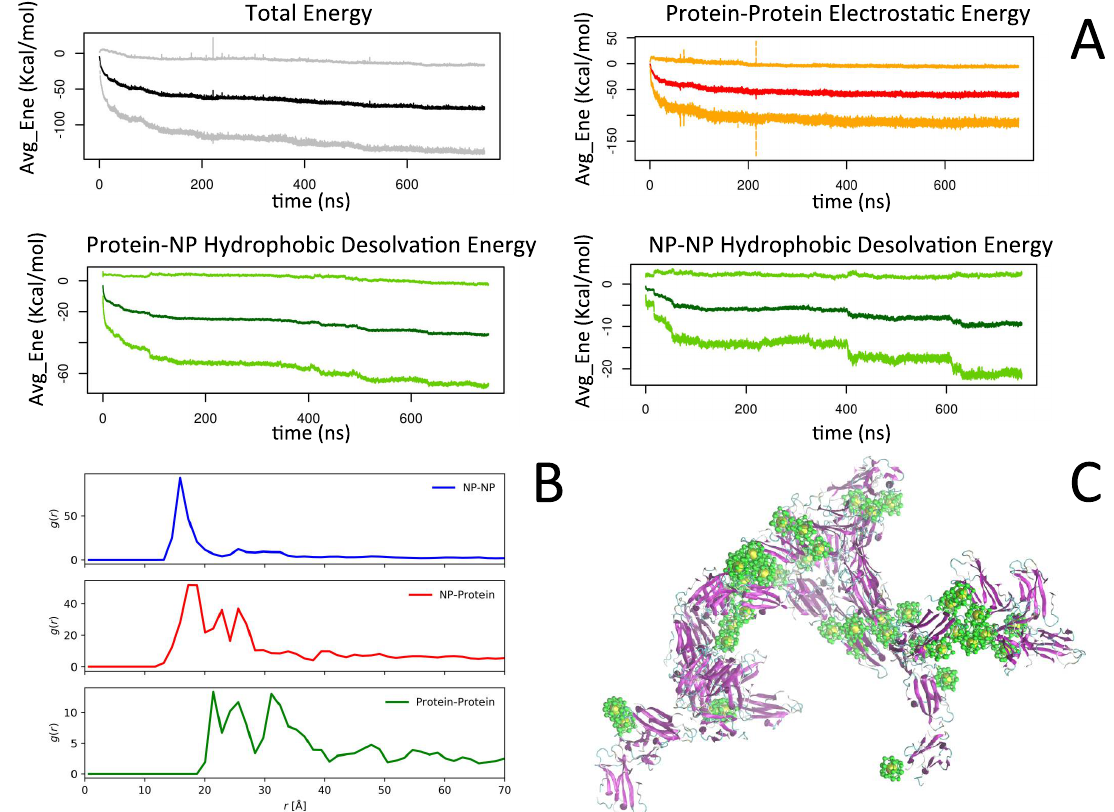
Figure 4. Summary of the CG simulations of ensembles of nanoparticles and proteins. ( A ) Energies terms contributing the most to the Total Binding Energy (in kcal / mol) collected during the dynamics of 1 µ s of simulation at 300 K. ( B ) Radial Distribution Function of the pairs NP-NP, NP-Protein, and Protein-Protein at the CG level. ( C ) Snapshot of the final configuration. Protein all-atom reconstruction was performed with PULCHRA